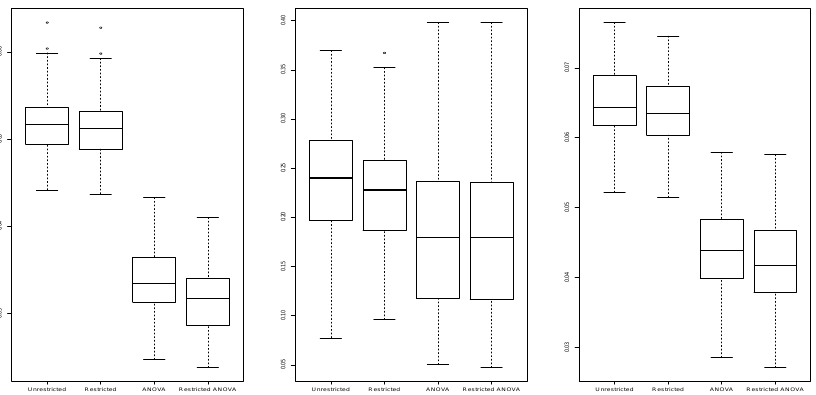
Figure 10. MAE in the fit ( left ), in the forecast ( middle ) and in total ( right ) of smooth models in = 0 and n x = scenario 2 and n z p p